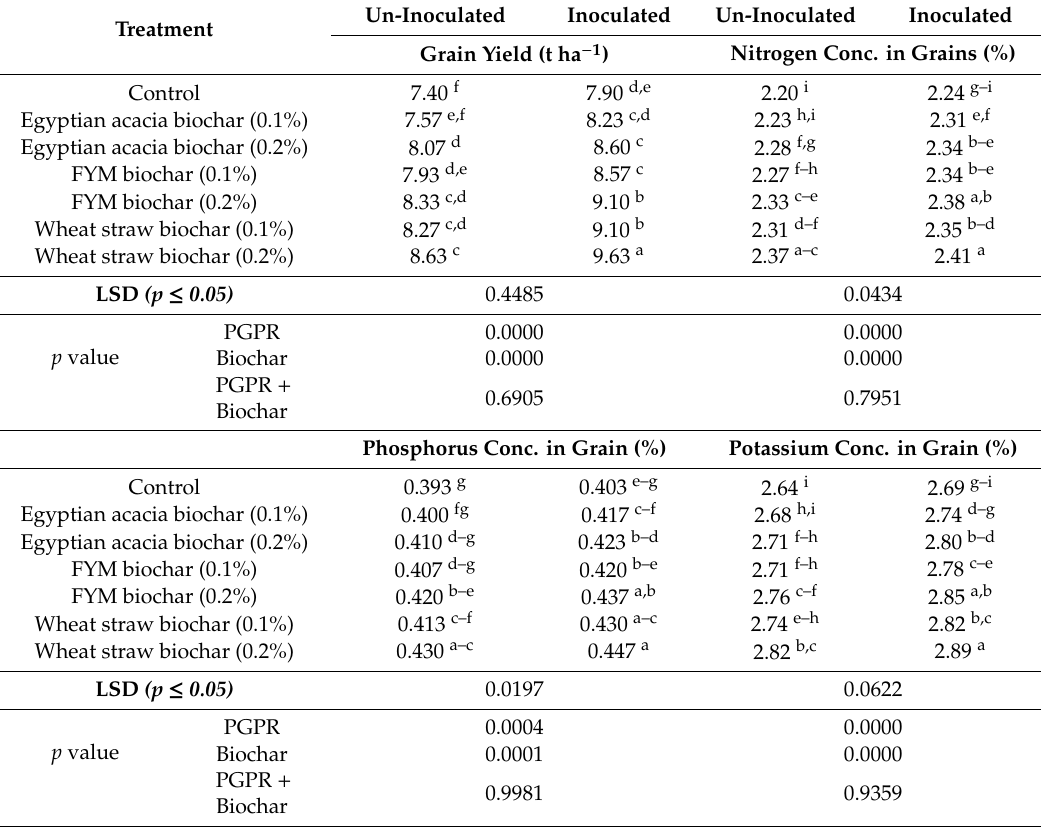
Table 6. E ff ects of biochar with and without Bacillus sp. ZM20 on grain yield, and nitrogen, phosphorus, and potassium concentrations in grain of maize in field